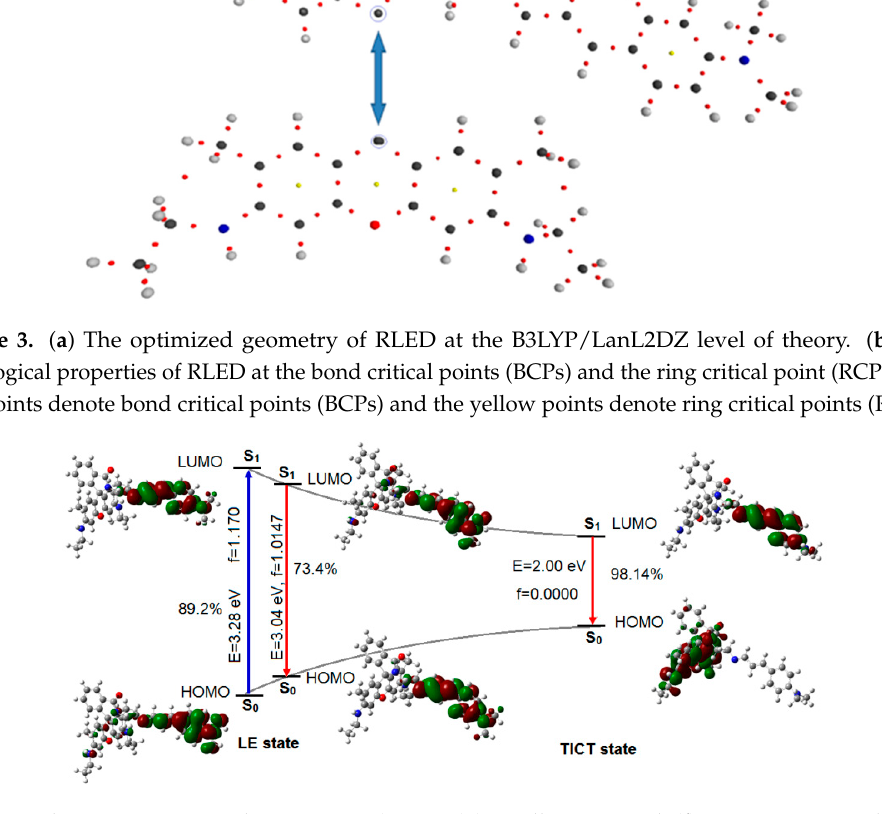
Figure 4. The main transition characteristics (energy (E), oscillator strength (f), percentage contribution, and frontier orbitals) of the excitation and emission processes at the locally excited (LE) state and twisted intermediate charge transfer (TICT) state of RLED at the B3LYP/LanL2DZ level.